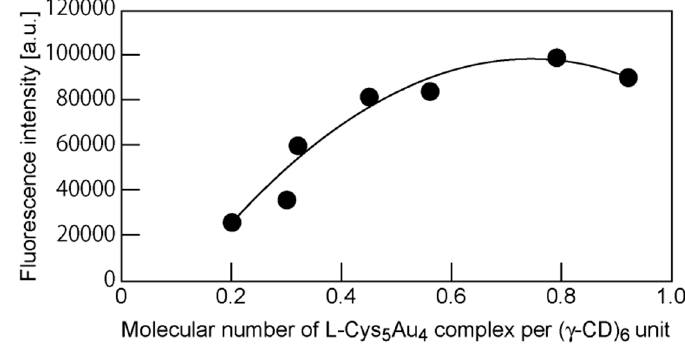
Figure 9. Relationship between the fluorescence intensity of L-Cys/Au(I)@CD-MOF and the number of L-Cys/Au(I) complexes per ( γ -CD) 6 unit. (wavelength = 668 nm).